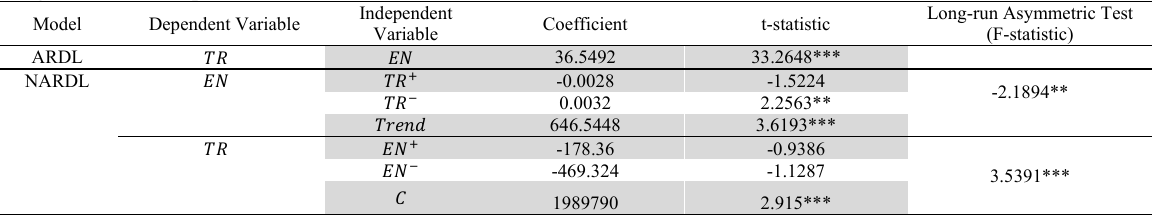
Long-run relationship.